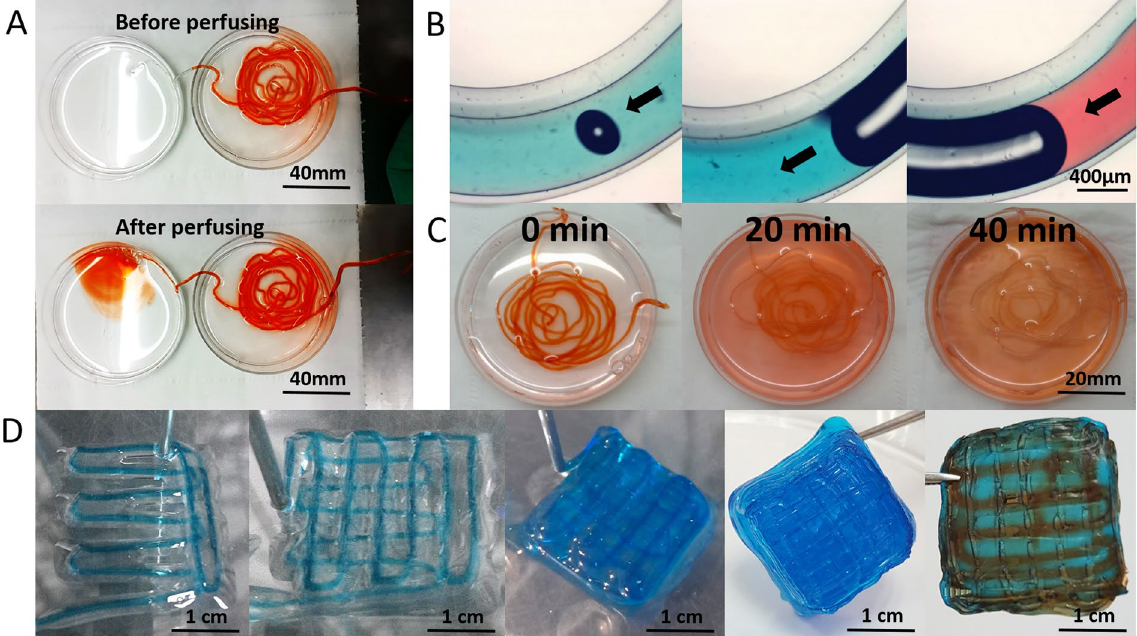
Figure 2. Characteristics of the core-shell structures. ( A and B ) Integrity and continuity of the extruded liquid flow: the solution in the core stained with red or blue dyes can flow through the printed fiber shell without leaking out; ( C ) Permeability: Dye can uniformly diffuse out the structure within 40 minutes; D Layer by layer bioprinting (left 1–4) and perfusion of the printed construct with red dyes (right 1). Scale bars: ( A ) 40 mm, ( B ) 400 μ m, ( C ) 20 mm, ( D ) 1